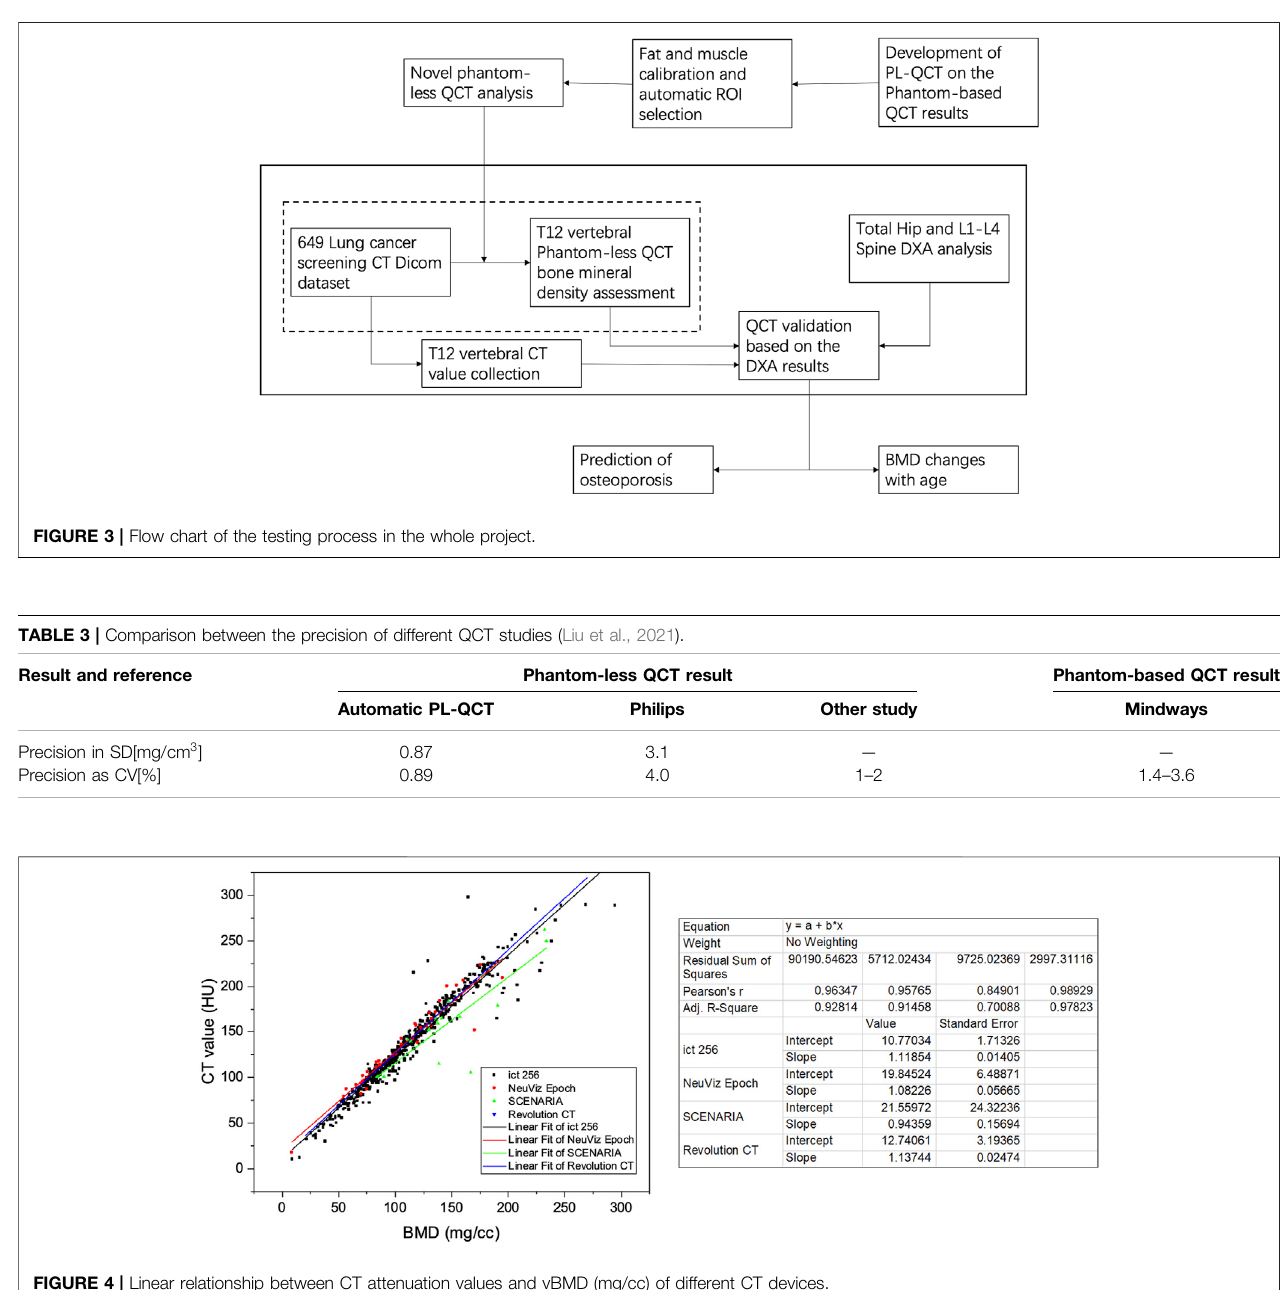
Frontiers in Bioengineering and Biotechnology |